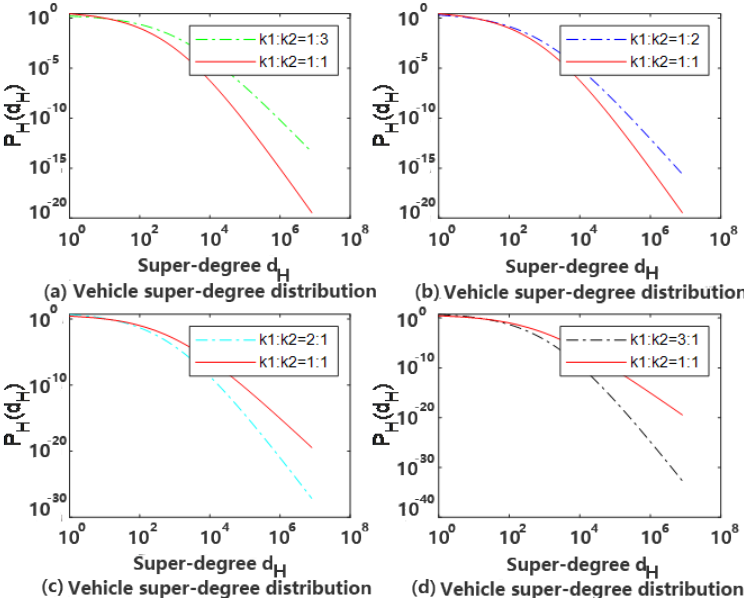
Figure 3. The characteristics with different k 1 : k 2 .